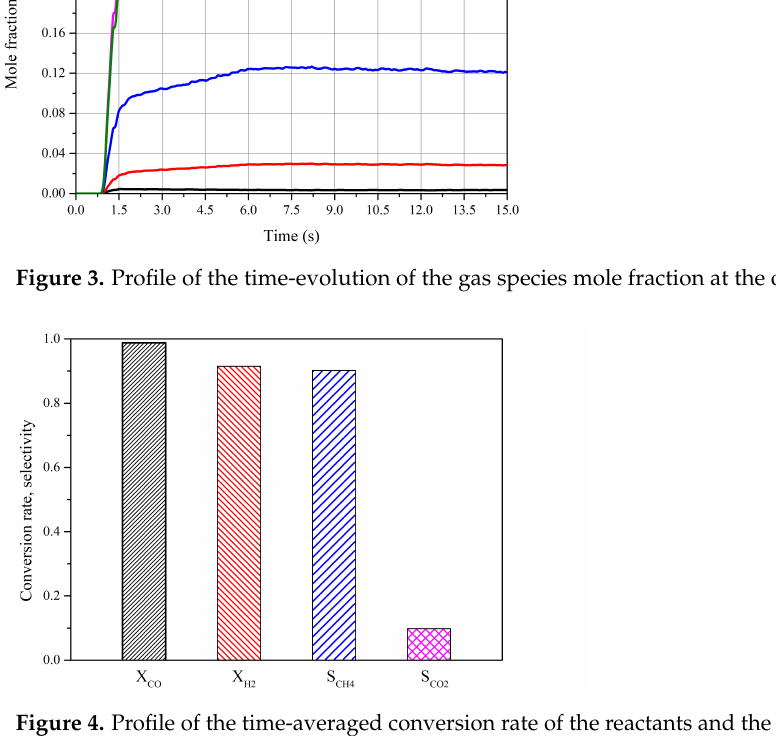
Figure 4. Profile of the time-averaged conversion rate of the reactants and the selectivity of products.